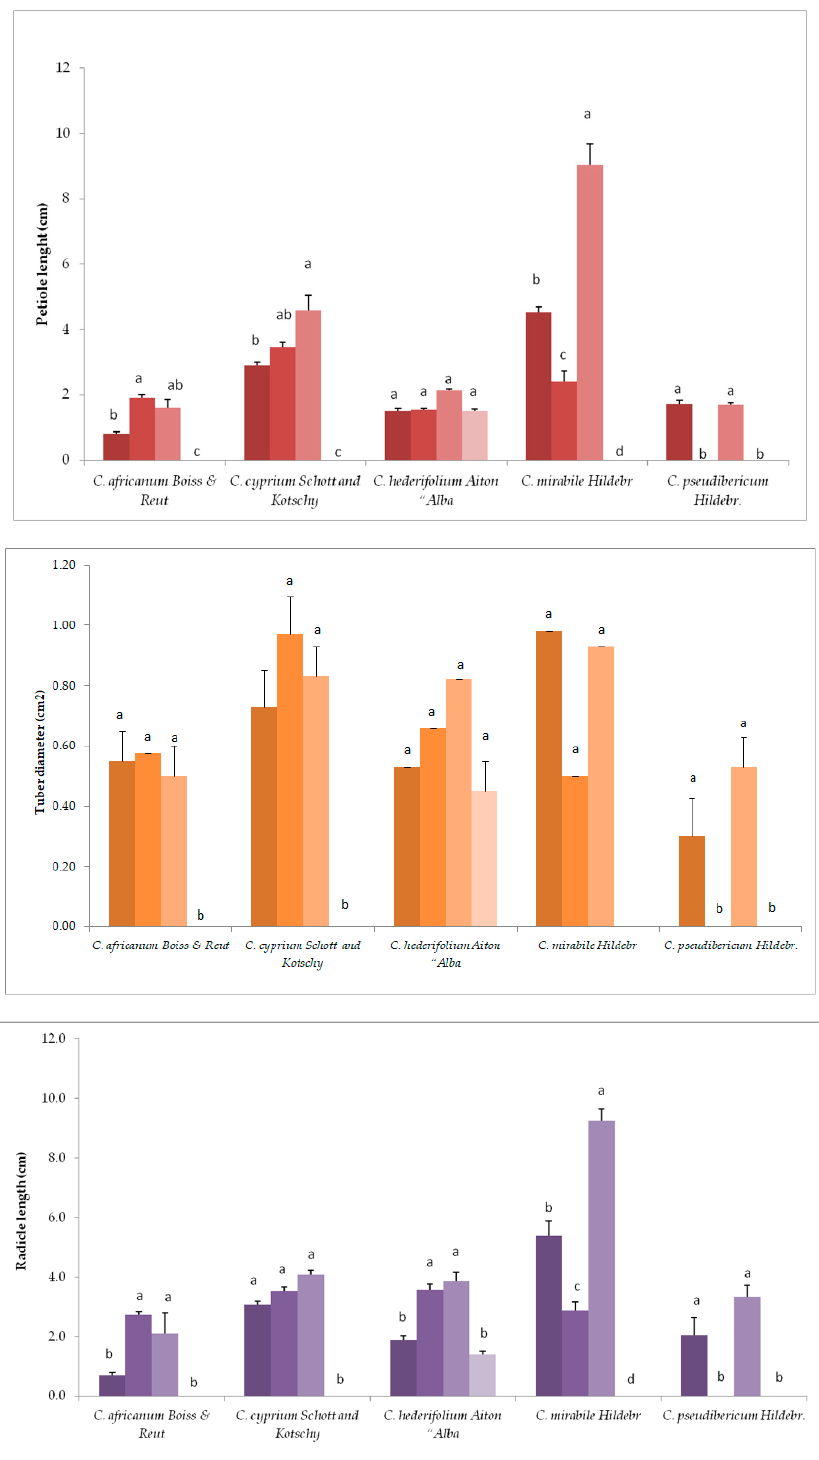
Figure 2. Variation of morphological parameters in Cyclamen species based on different concentration of gibberellic acid (GA 3 ). Different lowercase letters above the bars indicate significant differences between treatments, for each genotype, according to the Tukey’s HSD test ( p < 0.05).